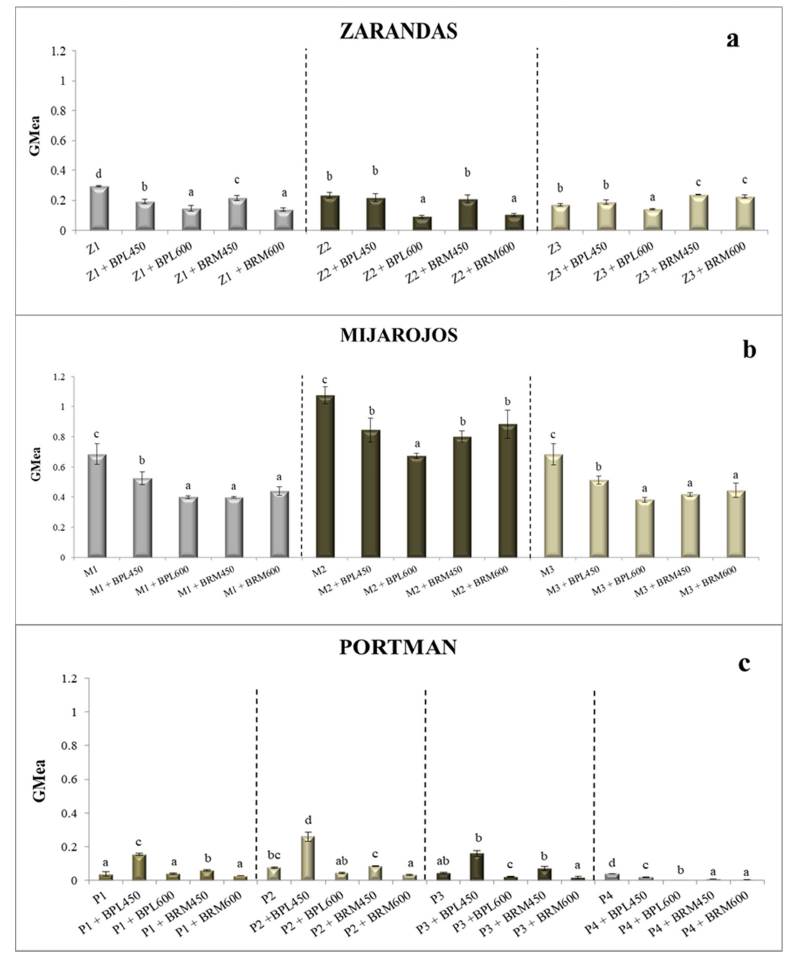
Figure 4. Geometric mean (GMea) of all samples after 180 days: a ) Zarandas-Andalusia area. b ) Mijarojos-Cantabria area. c ) Portman-area.